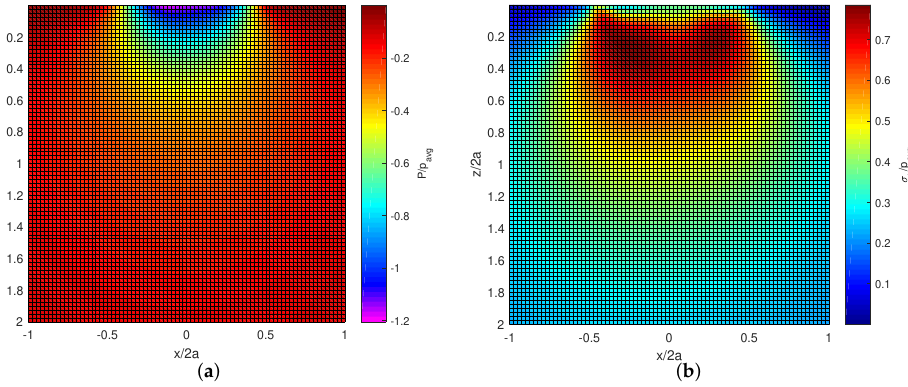
Figure 12. ( a ) The hydrostatic pressure P from Equation (28) under the combined normal and tangential traction boundary conditions shown in Figure 8 for Poisson ratio ν = 0.4. ( b ) The von Mises stress σ v from Equation (29) under the same